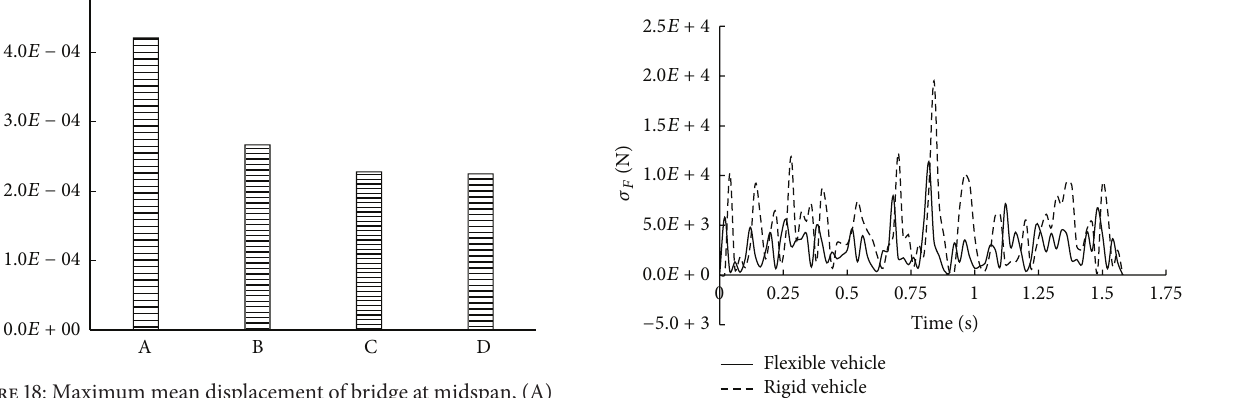
Figure 18: Maximum mean displacement of bridge at midspan, (A) rigid vehicle, (B) flexible vehicle only with first structural mode, (C) flexible vehicle with first three structural modes, and (D) flexible vehicle with first five structural modes.